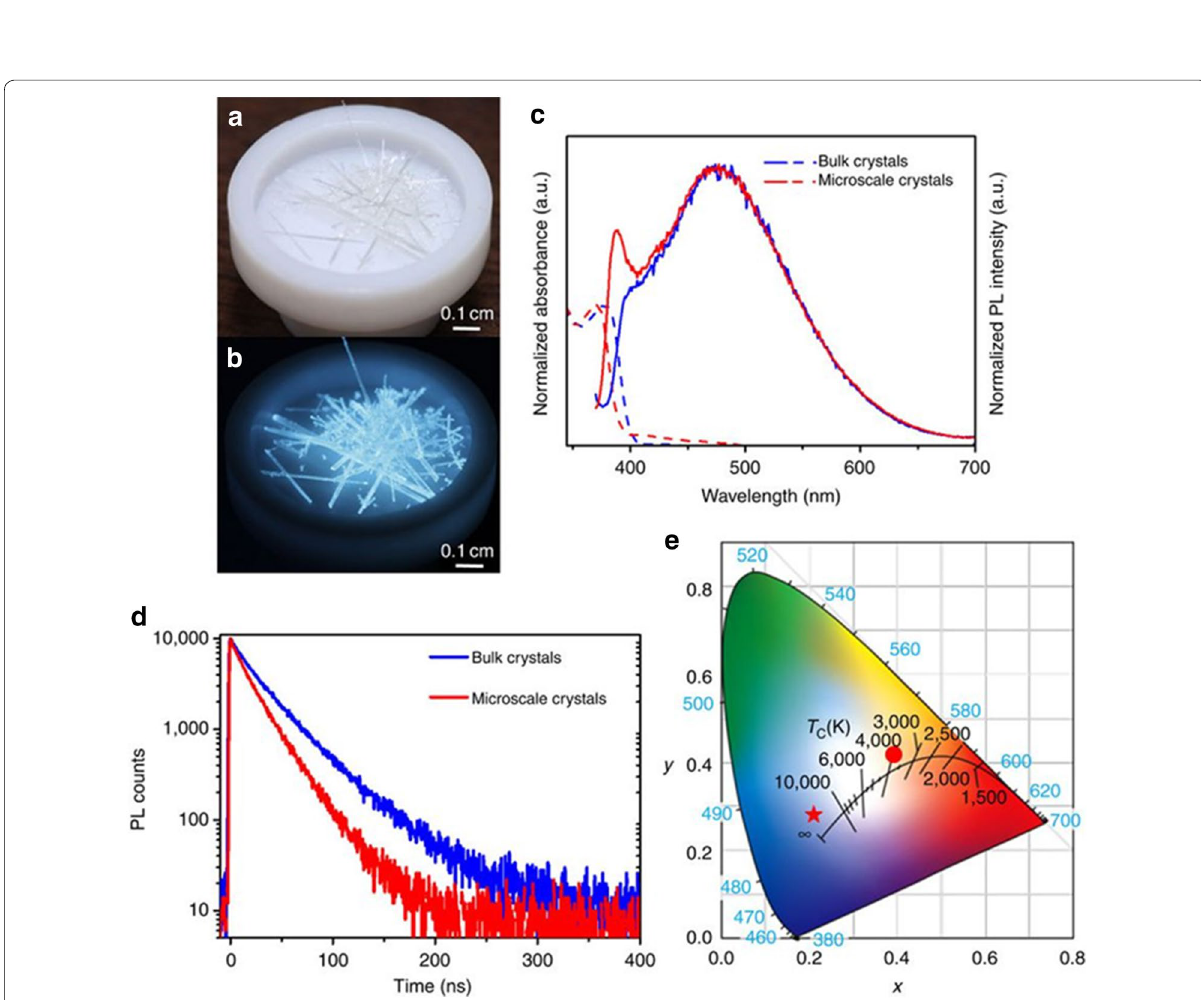
Fig. 24 Perovskite crystals at a ambient temperature and b UV light, c absorbance spectra and emission spectra of the bulk and micro-scaled perovskite crystals at room temperature, d TRPL study bulk and micro-scaled perovskite crystals, e CIE color coordinates of the white perovskites (Reproduced with permission from Ref. [68] Copyright 2017, Nature Publishing